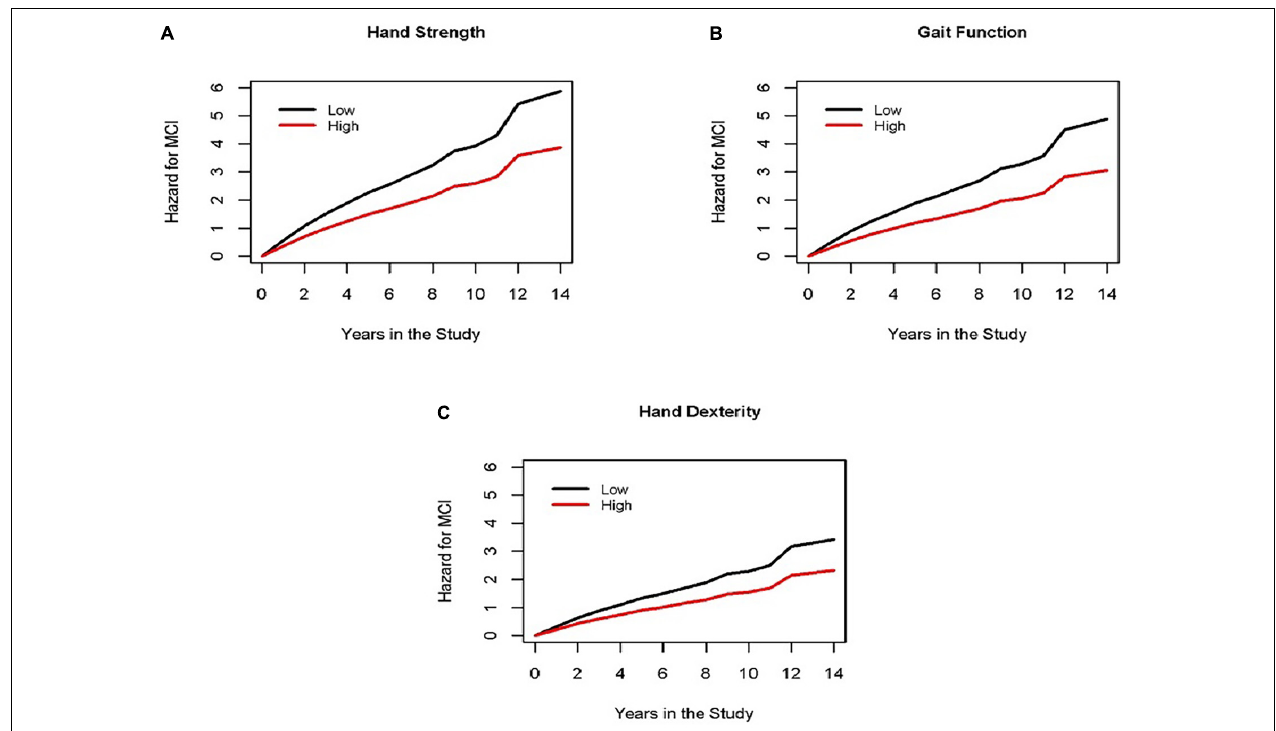
FIGURE 1 | Different motor domains are associated with incident MCI. Each panel ( A for hand strength, B for gait function and C for hand dexterity) shows the cumulative hazard of incident MCI during the study for two groups of average female participants, 73 years old, with 16 years of education with high motor function (red line, 90th percentile) vs. low motor function (black line, 10th percentile) at the study baseline for three different domains of motor function (representing results of Model 3 for incident MCI in Table 4